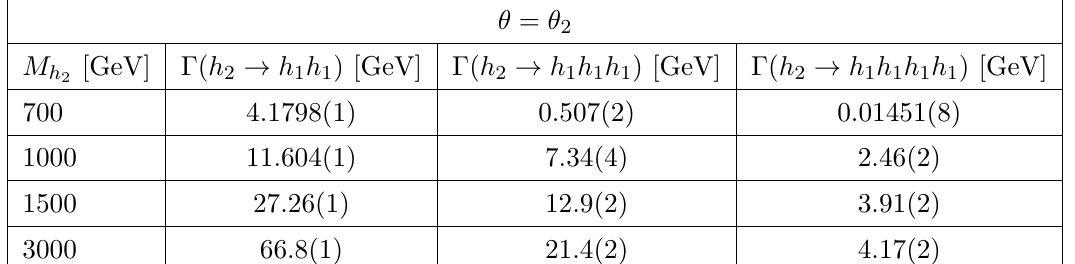
h h h h 1 1 1 1 . Other details as